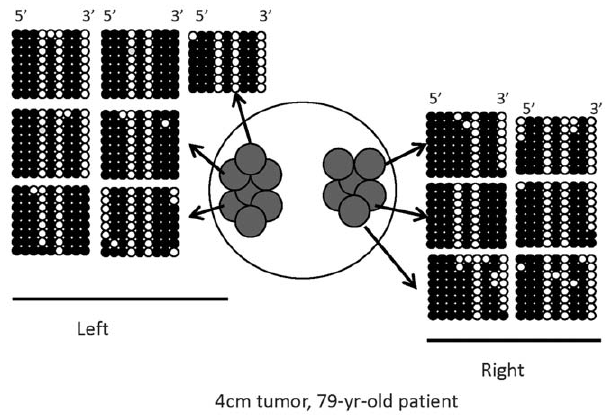
Figure 2. Tumor sampling scheme with bisulfite sequence data generated from one colorectal tumor. Grey circles denote cancer glands. Six to seven glands are sampled from each tumor half and multiple clones are sequenced for each tumor gland (e.g. 7–8). Black circles denote methylated CpGs and white circles unmethylated CpGs. Three physical distances: within a cancer gland, between cancer glands from the same tumor half, and between cancer glands from opposite tumor